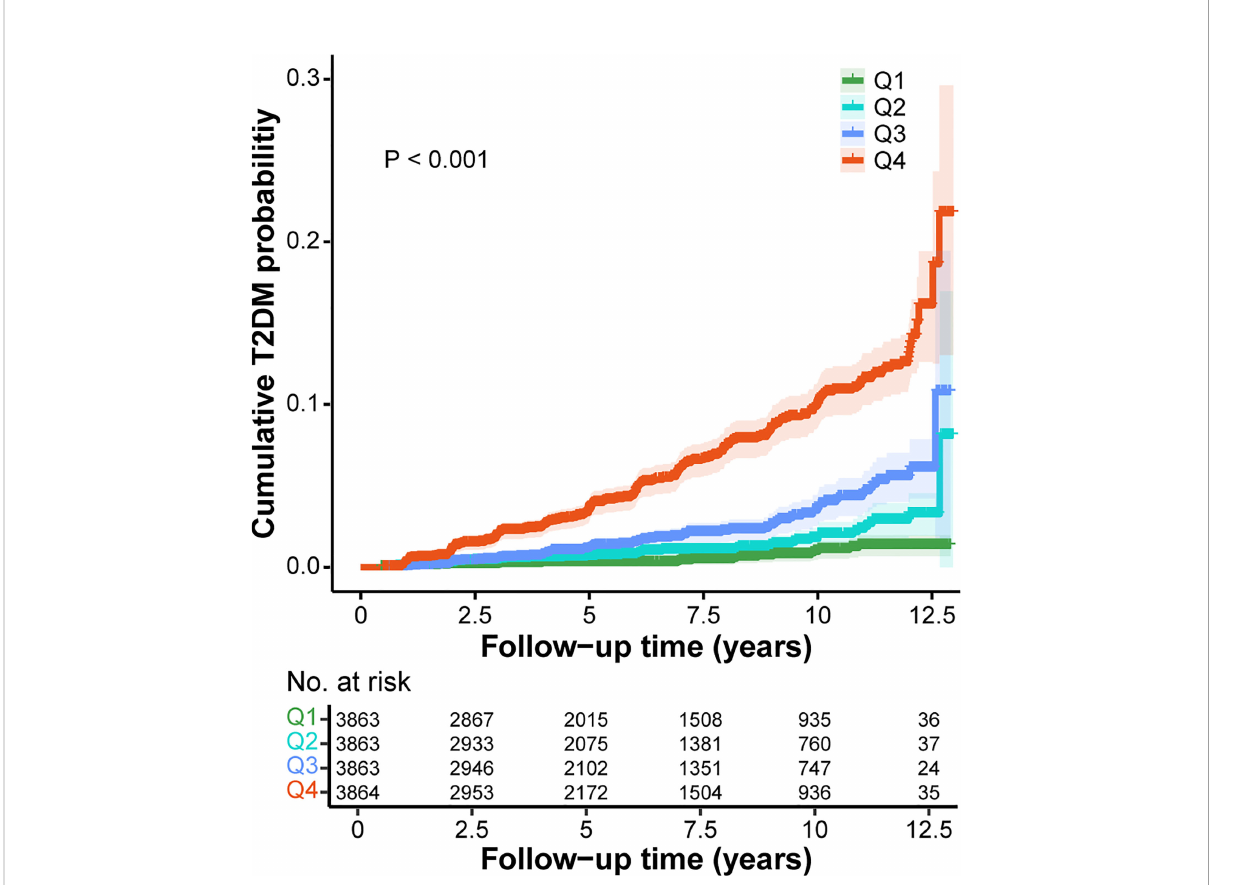
FIGURE 2 Kaplan-Meier curves for the cumulative T2DM probability according to different GGT/HDL-C ratio. Q1, < 7.20; Q2, 7.20-10.78; Q3, 10.78-17.96; Q4, >17.96. GGT, gamma-glutamyl transferase; HDL-C, high-density lipoprotein cholesterol; T2DM, type 2 diabetes